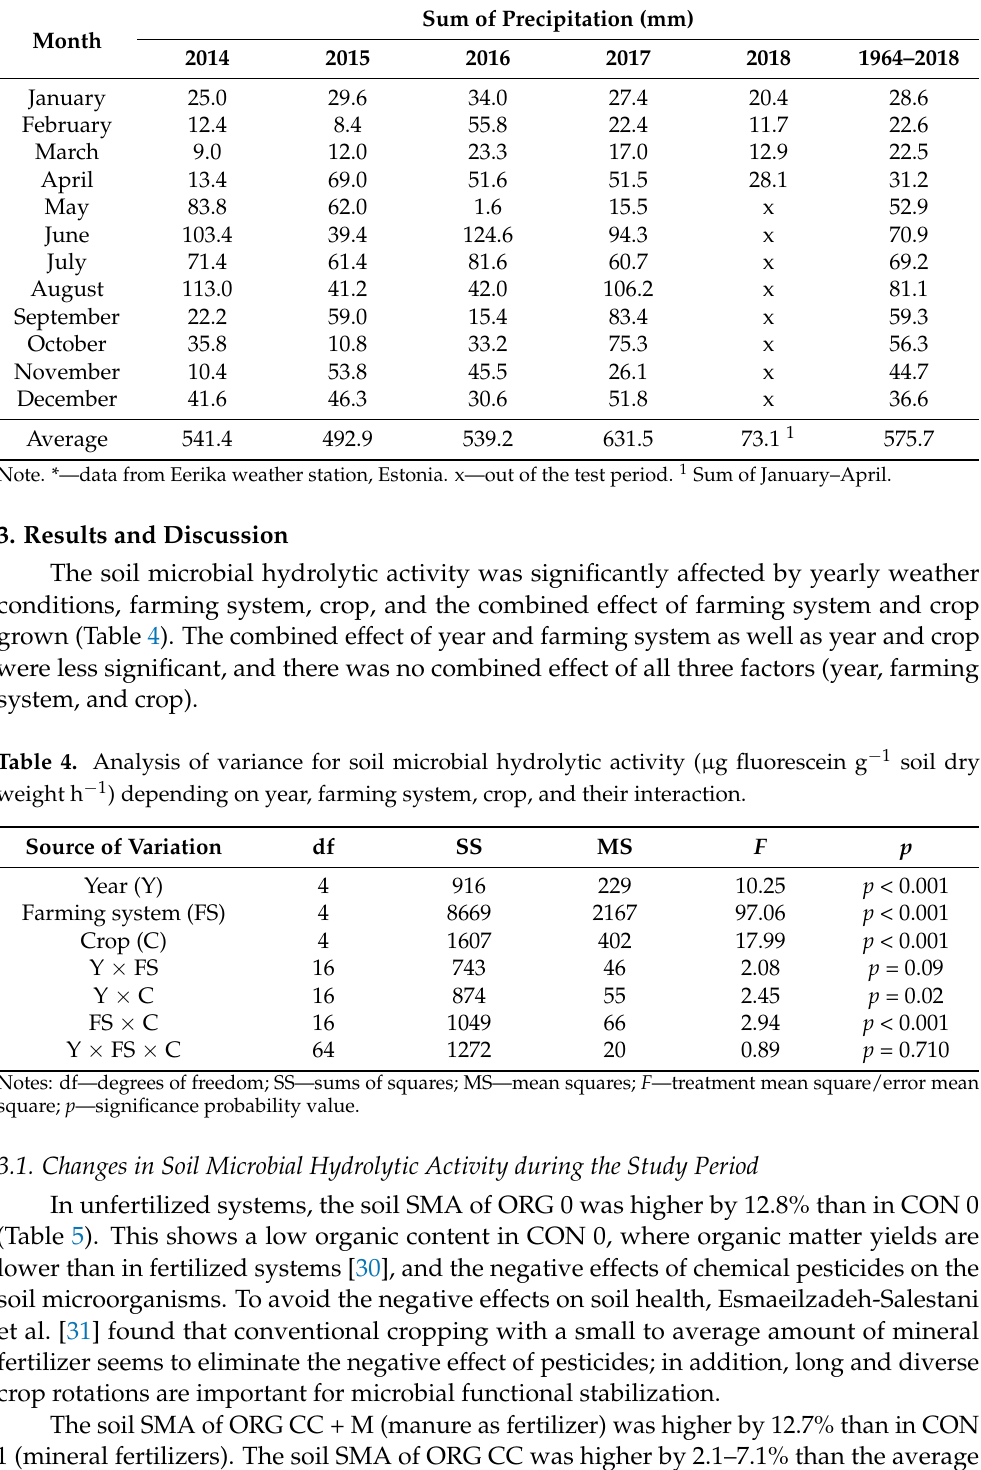
Table 3. Sum of precipitation (mm) in 2014–2018 compared to the long-term average (1964–2018) data *.